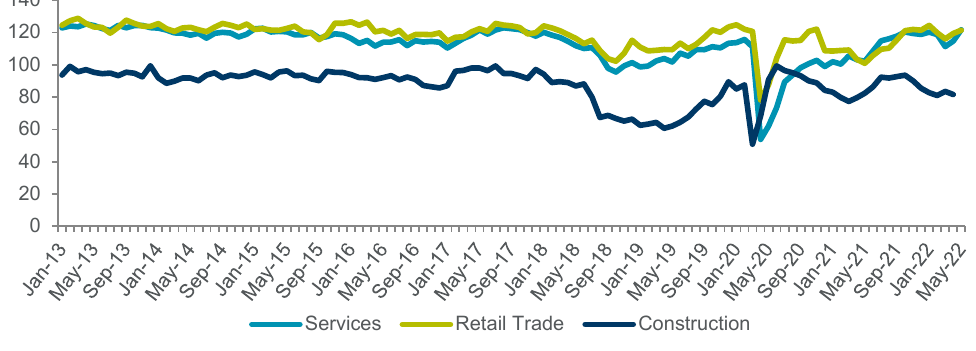
Figure 8 Sectoral Confidence Index, TURKSTAT,